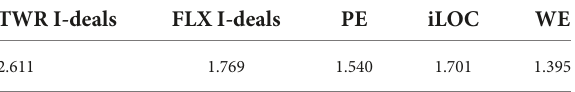
TABLE 4 Assessment of full